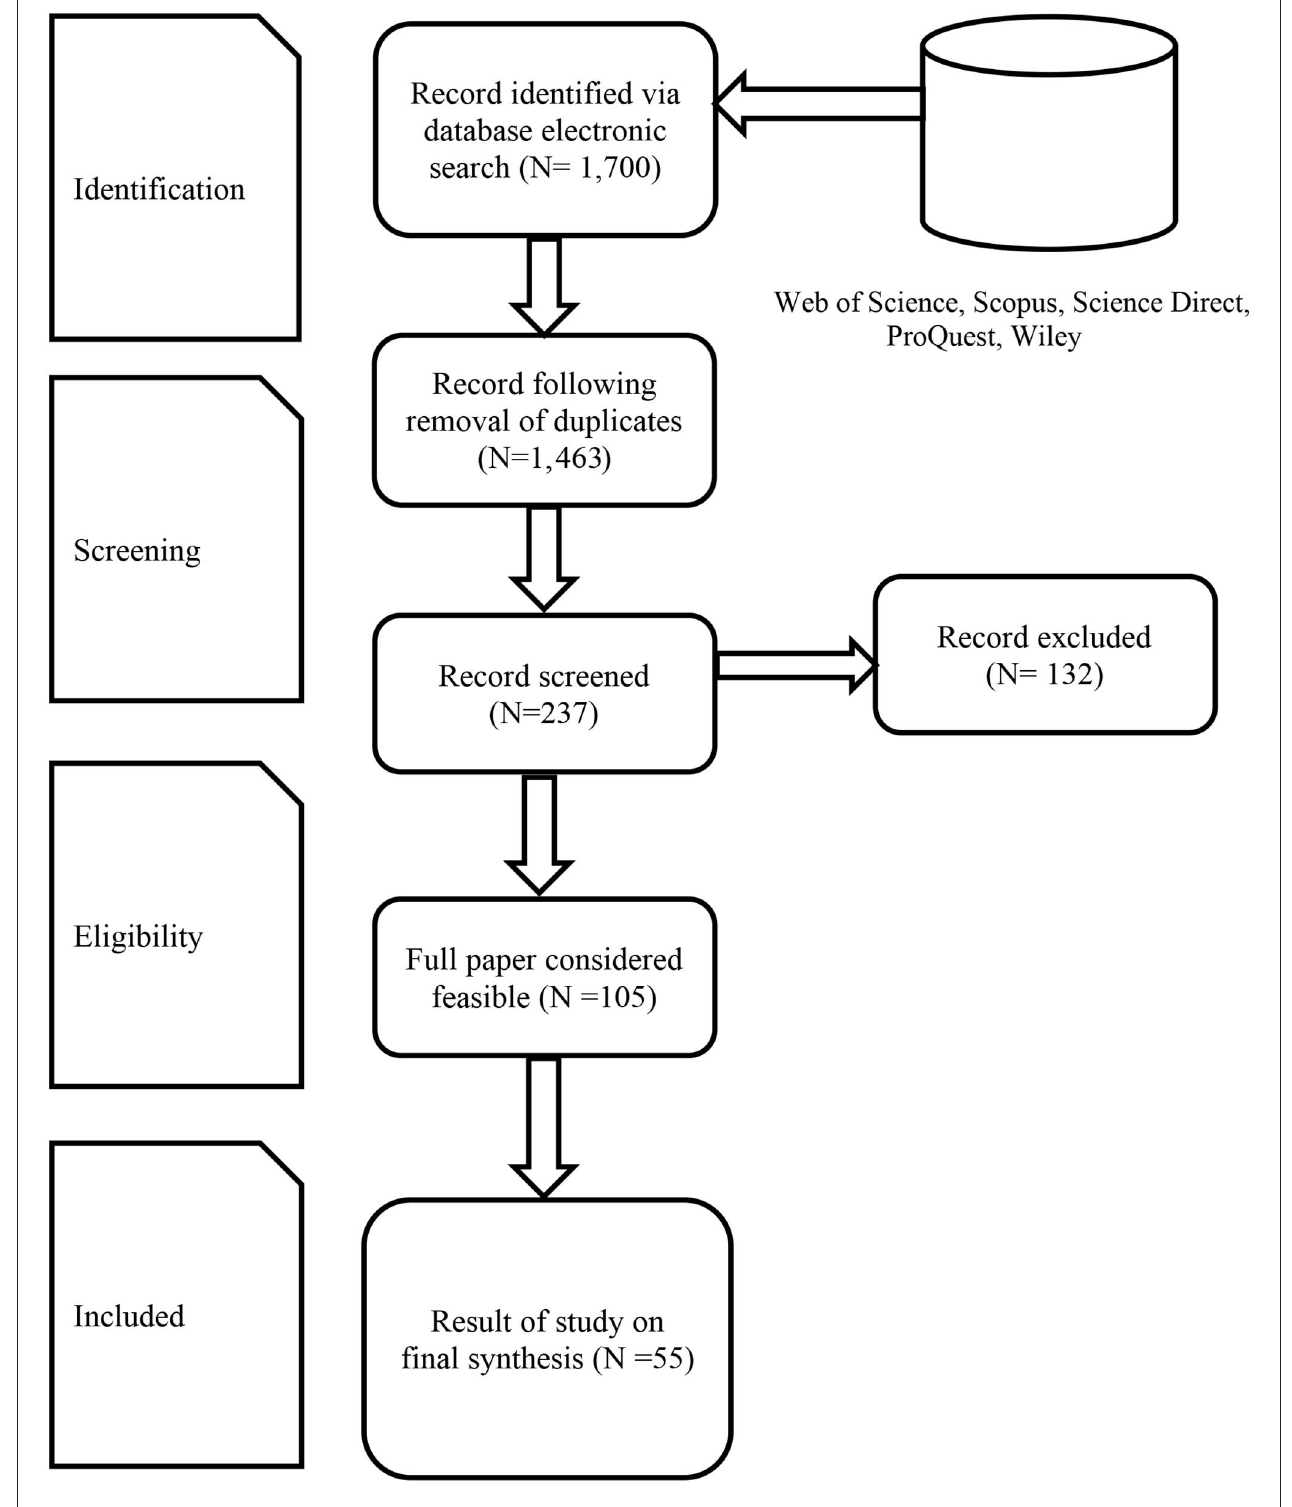
FIGURE 1 | PRISMA flow